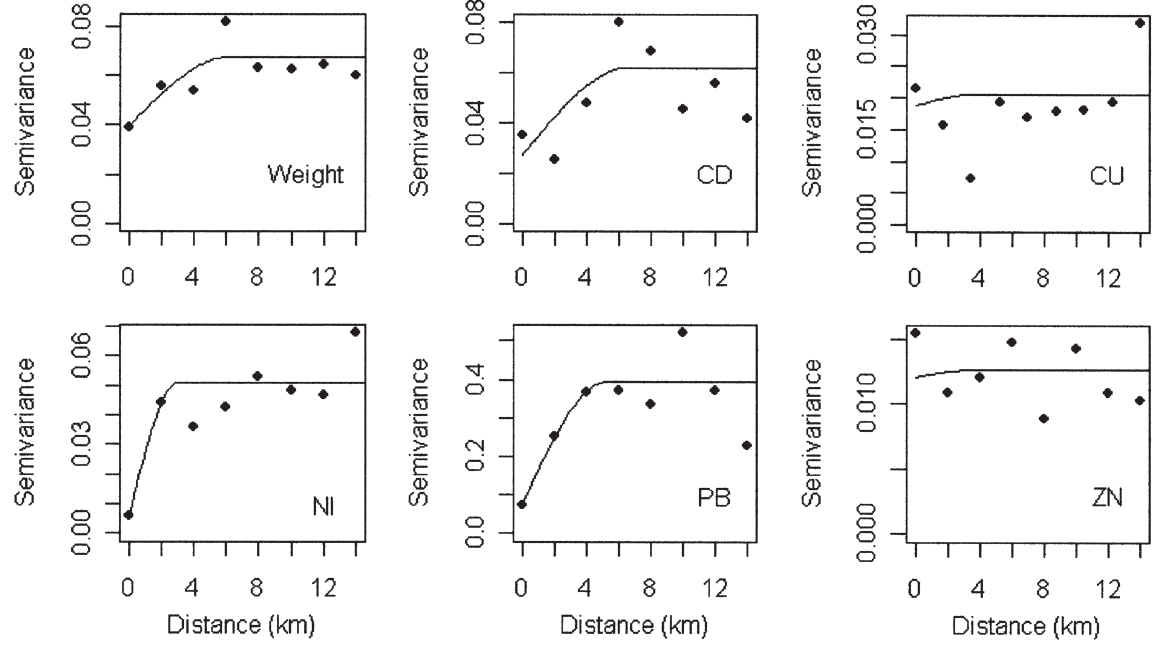
Fig . 3. – empirical semivariograms with fitted spherical models for weight ( mbww = mean body wet weight of shrimps per sample in g), Cd , Cu , ni , Pb , and Zn in Crangon crangon (mg kg -1 dW, respectively) within Box a (Fig. 1). Table 2. – estimated parameters of spherical semi-variogram models (Fig. 3) fitted to sample values of corresponding variables measured for Crangon crangon from Box a (Fig. 1). Variable trend